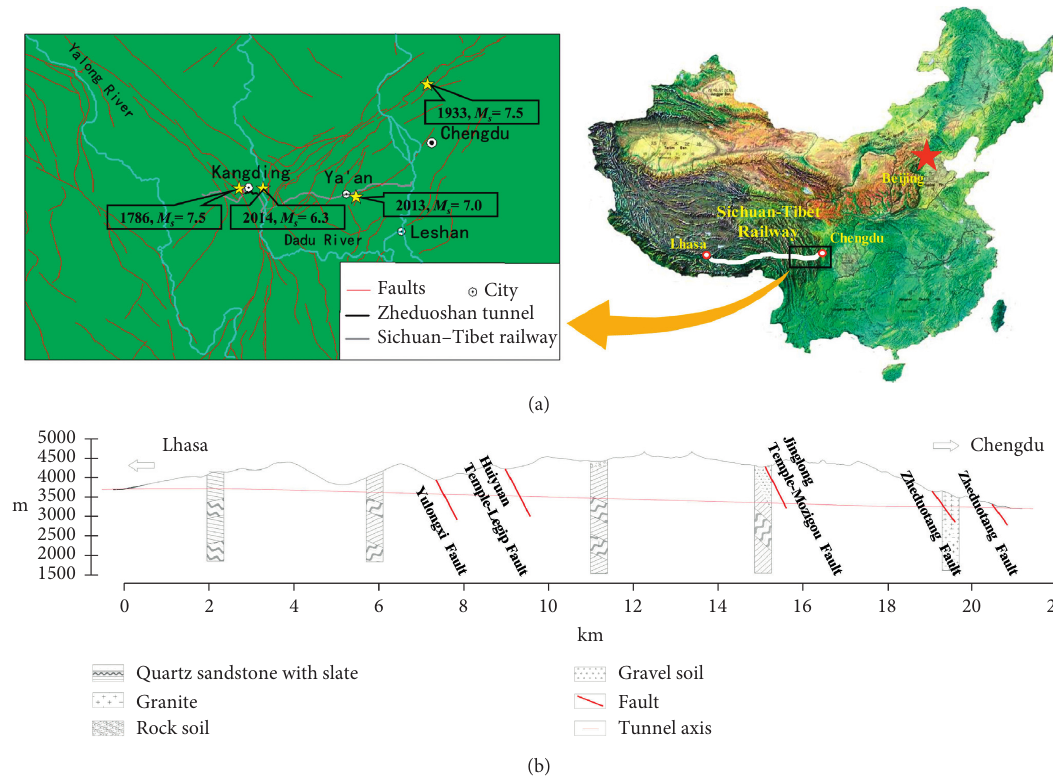
Figure 1: (a) Location of the Zheduoshan tunnel along the Sichuan-Tibet railway line and the earthquake events. (b) Geological profile along the Zheduoshan tunnel.